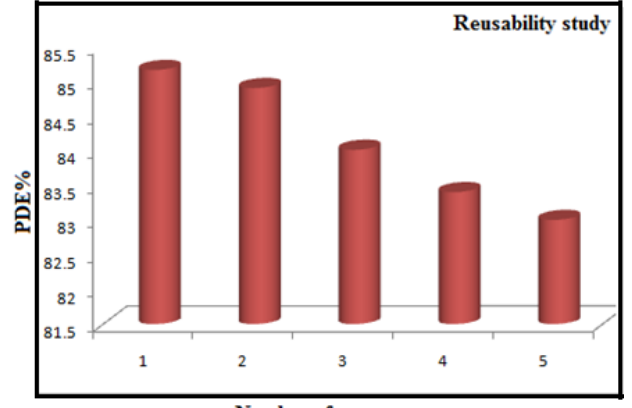
Fig.12. Reuse of catalyst at conditions: dose (2.0) g/100mL, conc. = 30 ppm, initial pH of solution= 5.5 and T= 303K for Congo red